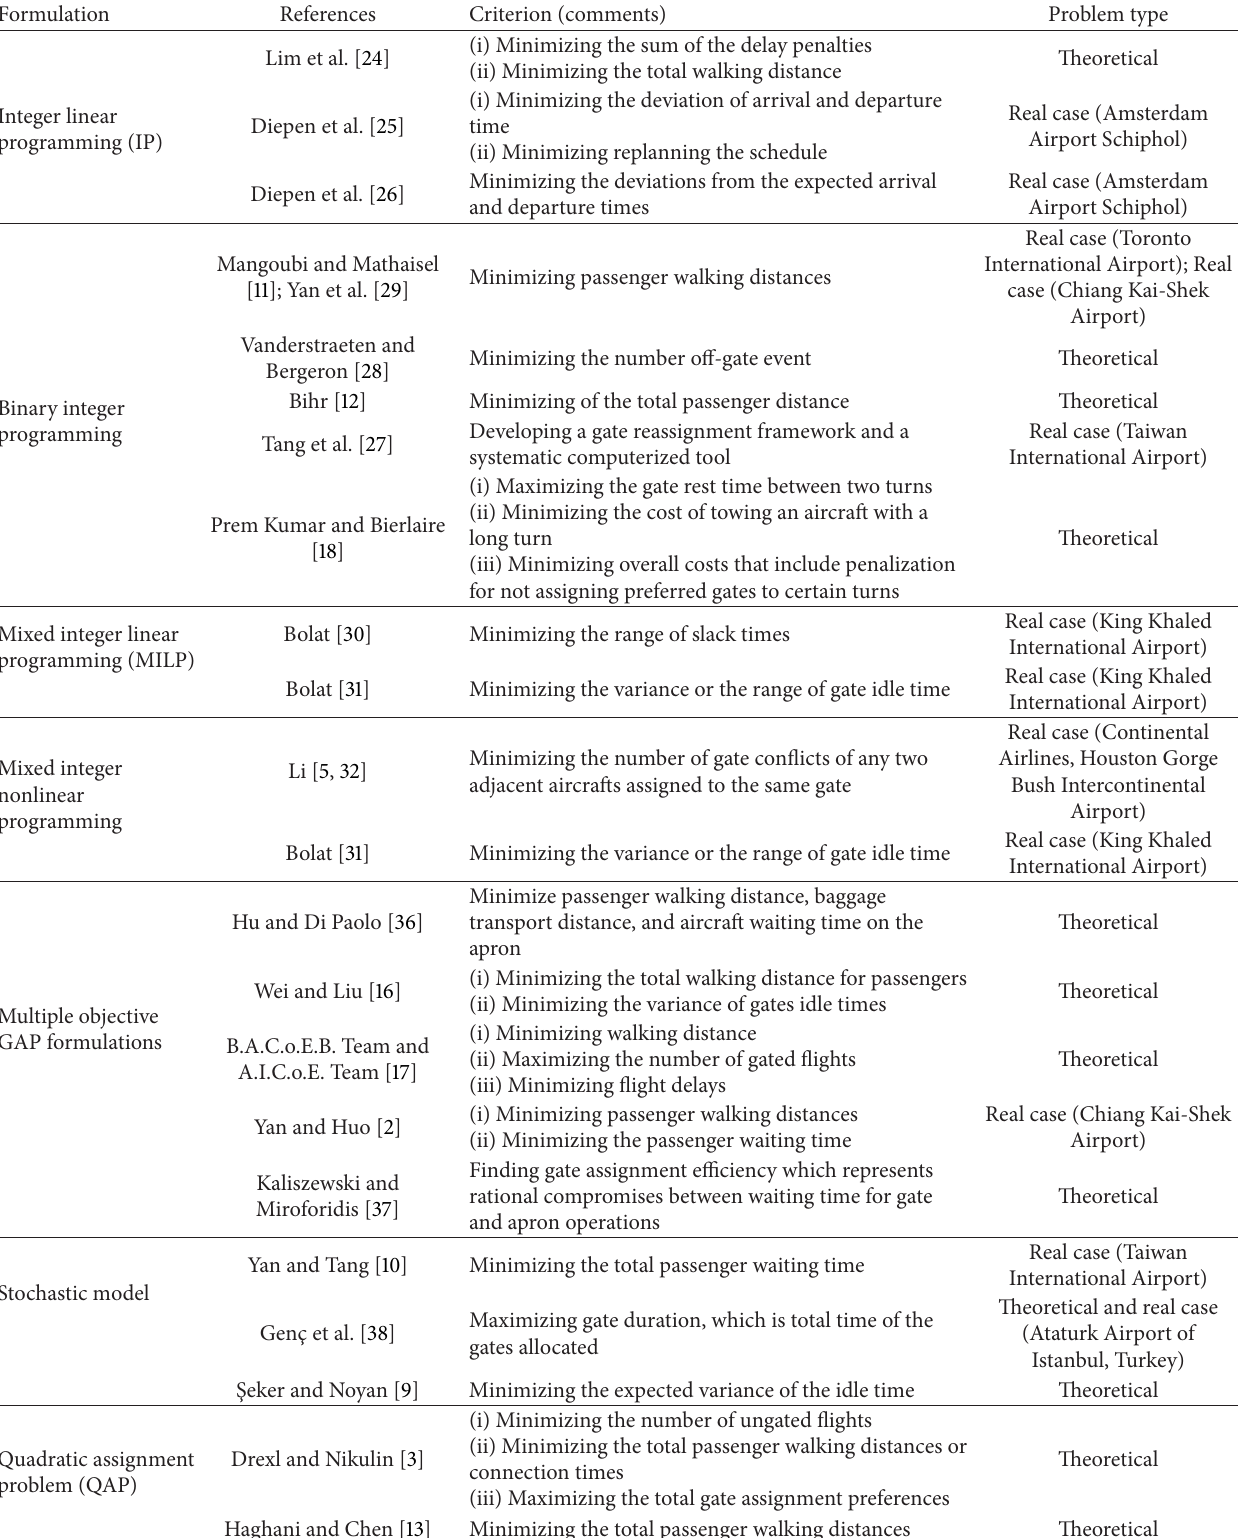
Table 1: Formulations of AGAP and related